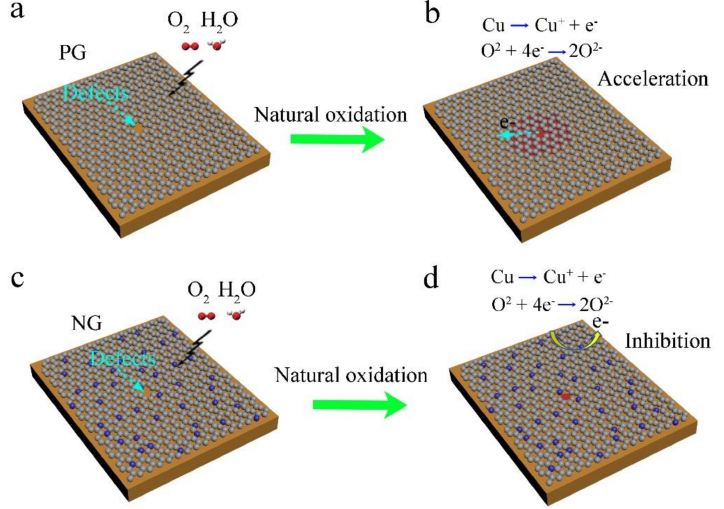
Figure 6. ( a , b ) Diagram of galvanic corrosion mechanism of copper by PG in long-term; ( c , d ) diagram of protection mechanism of copper by N-doped graphene in